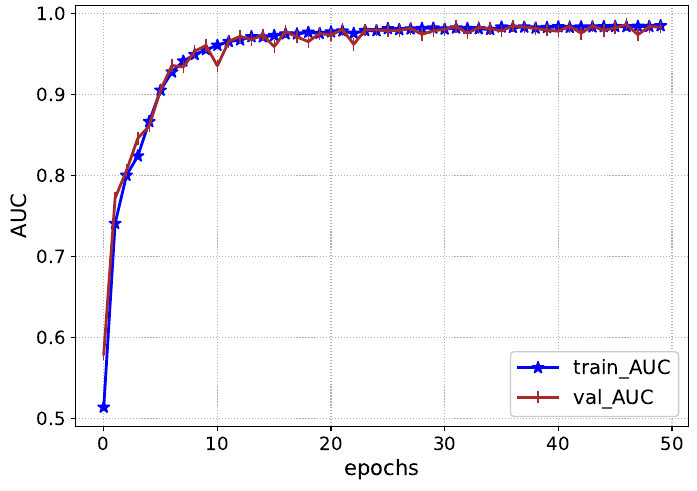
Figure 7. AUC during the training